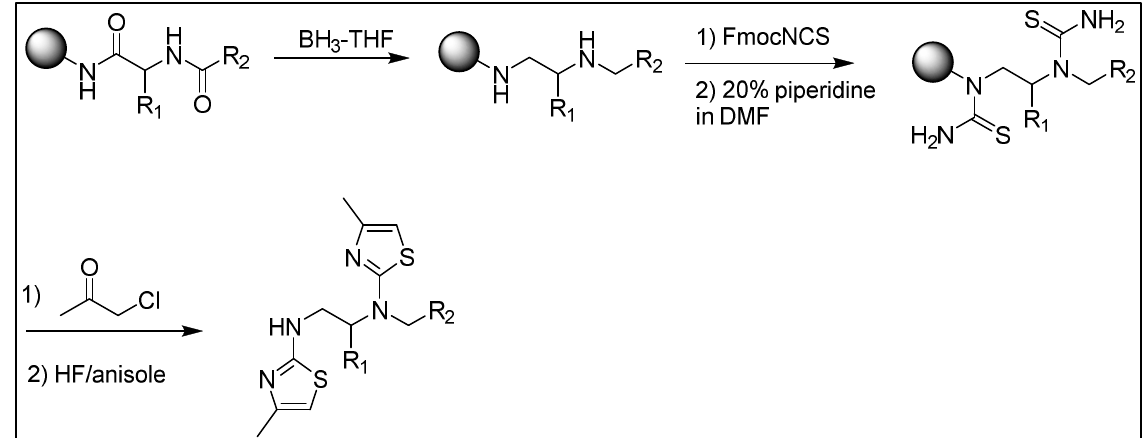
Figure 3. Inhibition of ICAM-1 binding to bead-immobilized PF11_0521 DBL2β3 domain by twenty-four mixtures (out of 50) with R 1 ( A ) and forty mixtures (out of 70) with R 2 ( B ) groups in TPI-2103 with highest binding inhibiting activity. Mixtures were assayed at concentration 2.5 μg/mL. We measured 100% binding in the absence of compounds, using binding buffer supplemented with the same concentration of DMF as samples with compounds. All groups selected for the synthesis of single compounds library (TPI-2648) are indicated by red color (active) and by black color (inactive). List of building blocks for R1 and R2 groups is also included in Supplementary Materials.